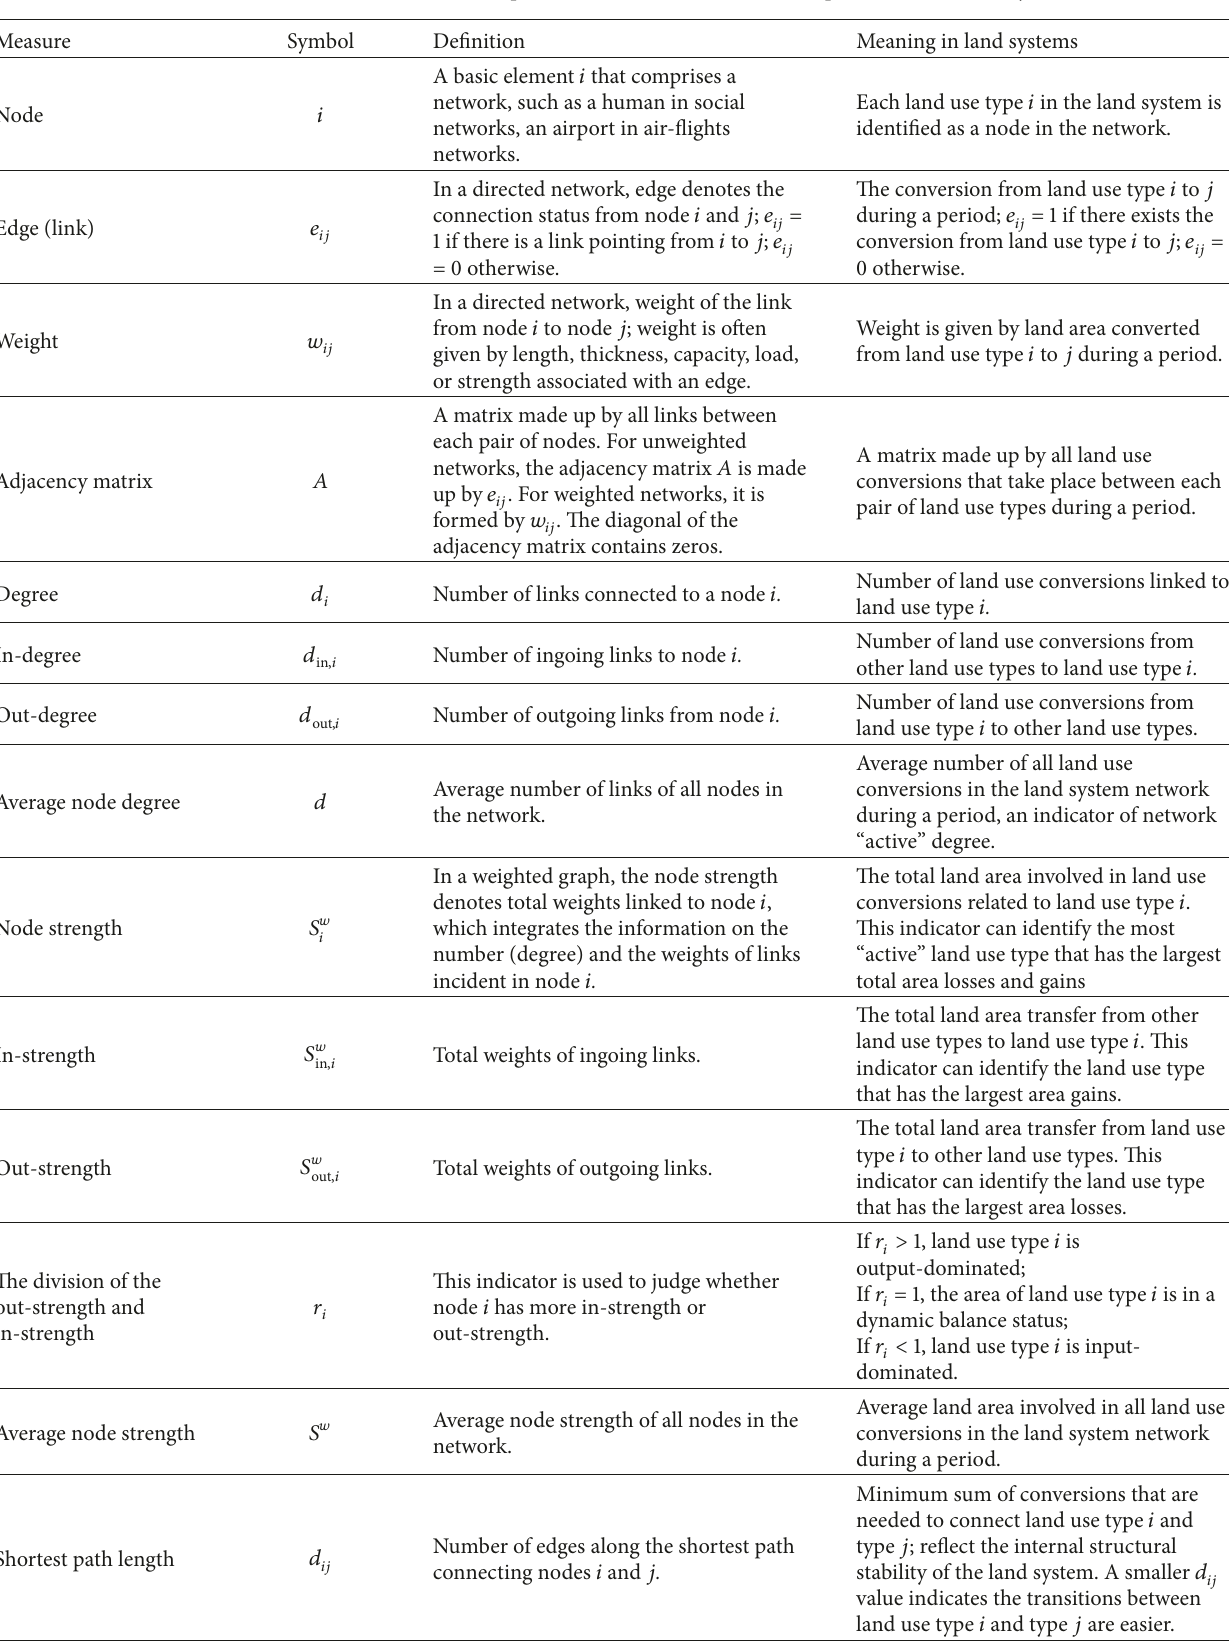
Table 1: Mathematical definitions of complex network measures and their representation in land